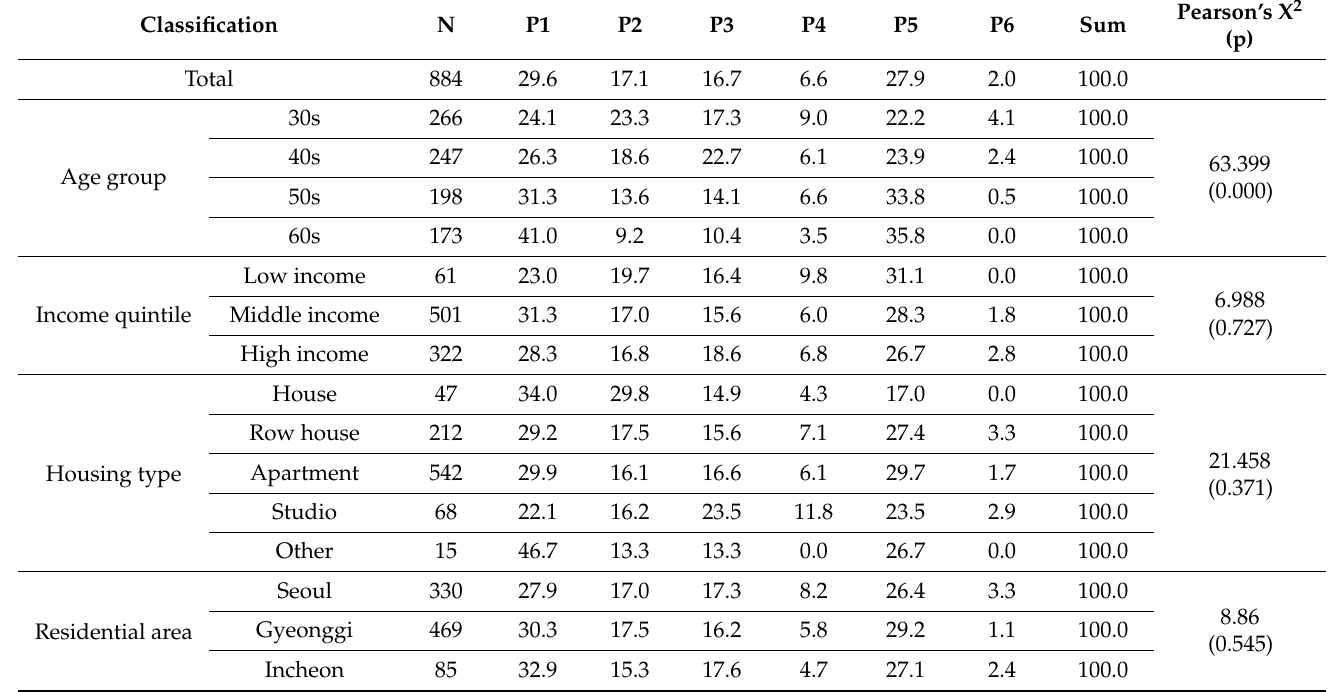
Table 4. Cross-analysis of the period of high awareness of street trees and demographic